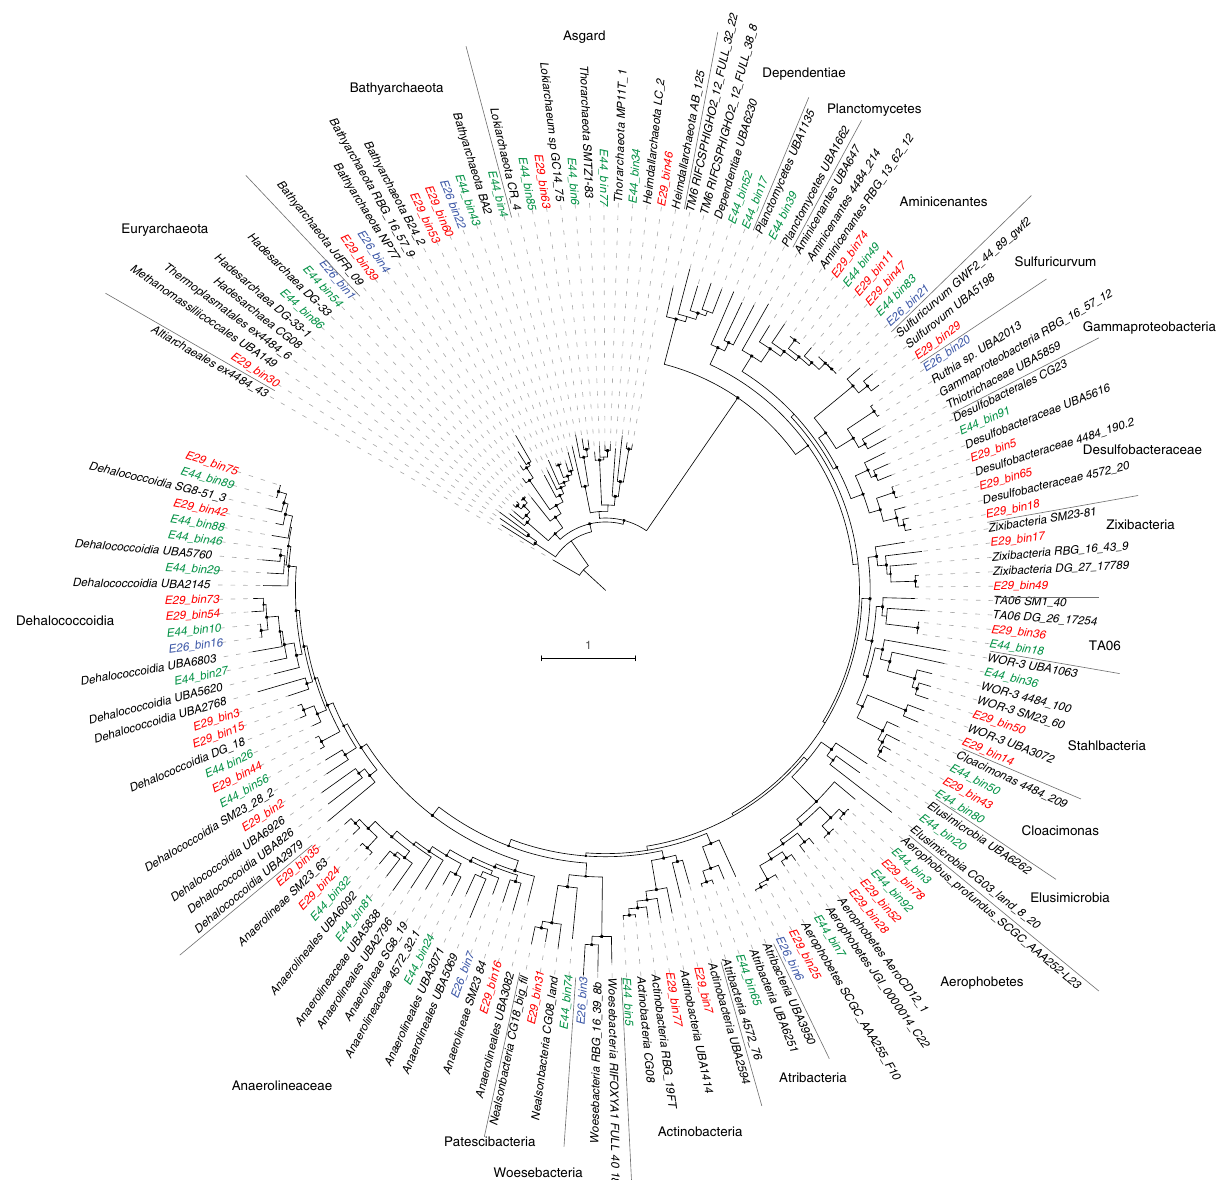
Fig. 2 Phylogenetic placement of 82 reconstructed metagenome-assembled genomes. A maximum-likelihood phylogenomic tree was built based on concatenated amino acid sequences of 43 conserved single-copy genes using RAxML with the PROTGAMMALG model. Sequences of Altiarchaeales ex4484_43 were used as an outgroup. The scale bar represents 1 amino acid substitution per sequence position. Bootstrap values >70% are indicated. Blue for Site E26 (E26_binX), red for Site E29 (E29_binY), and green for Site E44